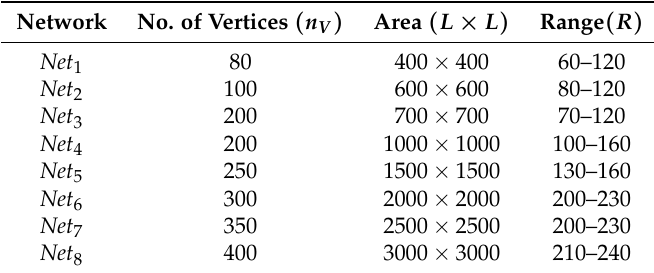
Table 1. Networks used in testing.